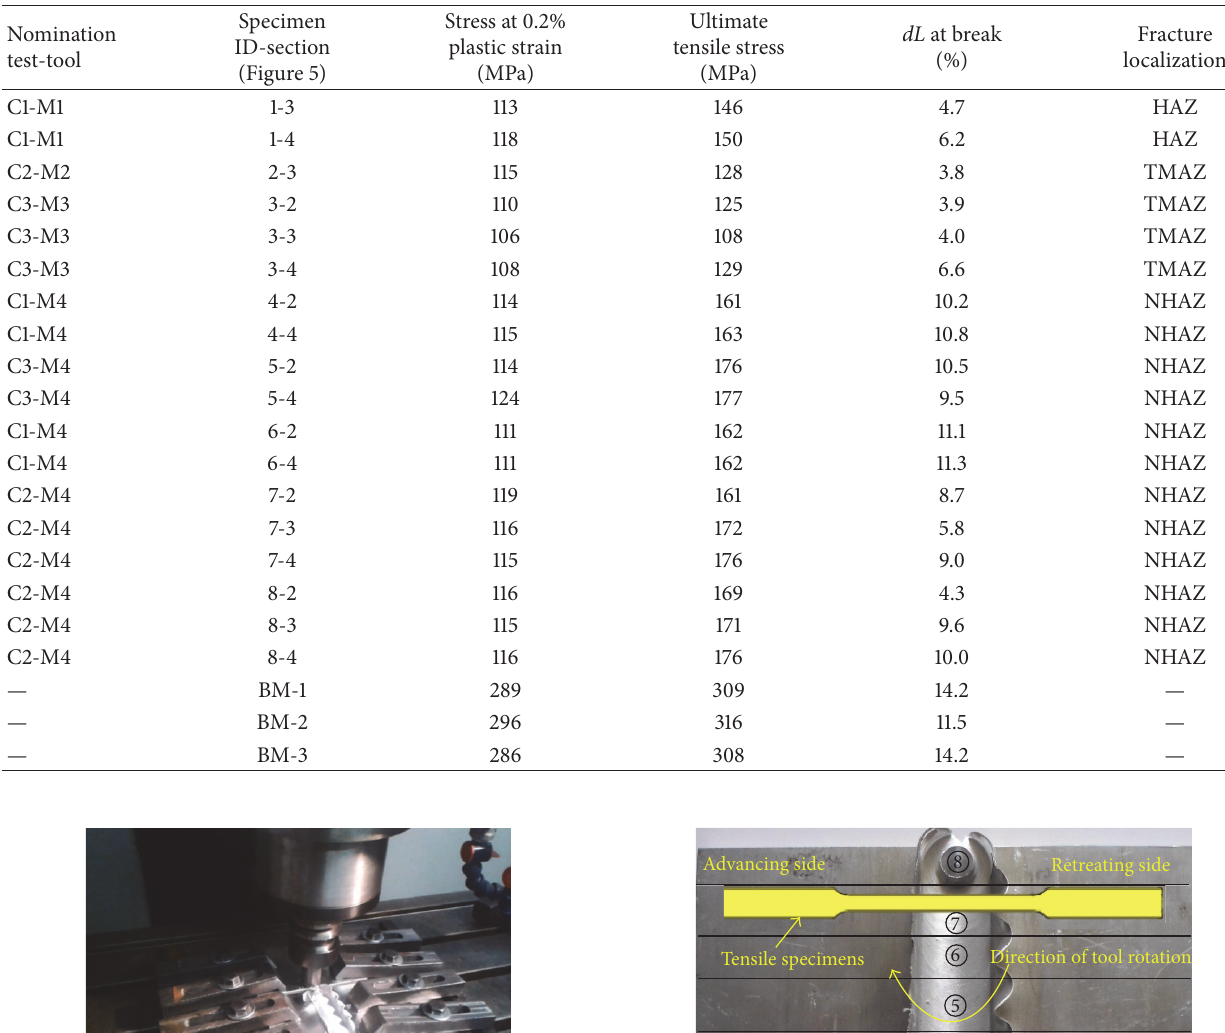
Table 5: Tensile tests for specimens welded by the SHBH pin profile and base material (BM) specimens.